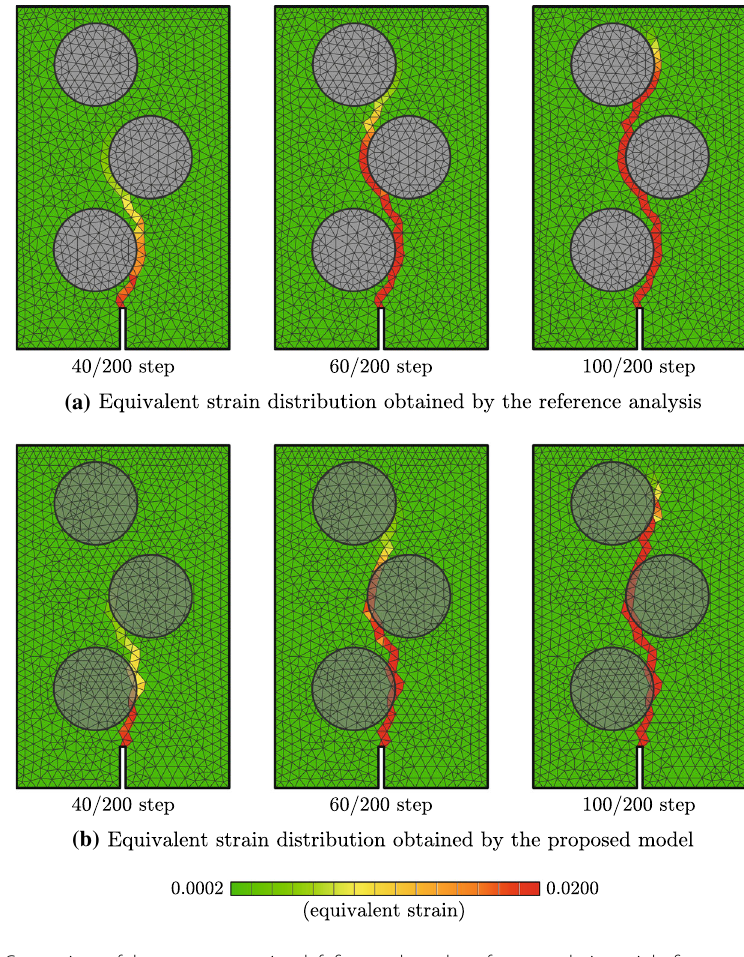
which takes the damage initiation strain as the minimum value, as shown in Fig. 10. For convenience, the strain localization caused by damage is referred to as “crack” in this